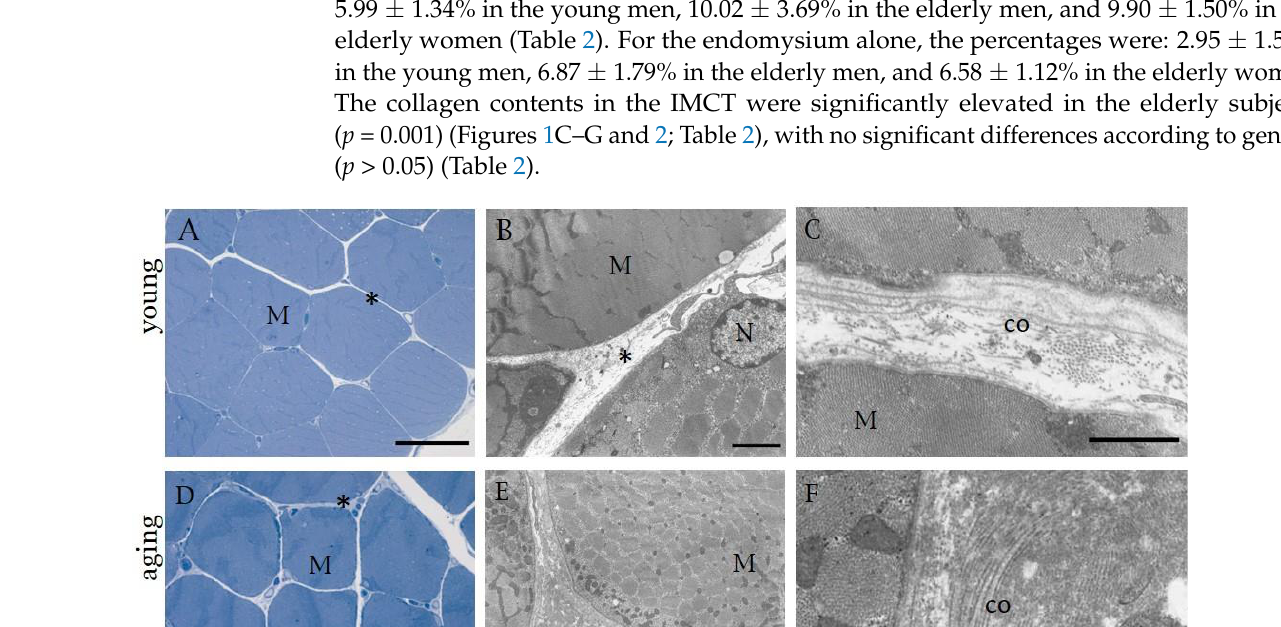
Unpaired, two-sample t -test, NA: not applicable. Values are presented as numbers or means ± SD.